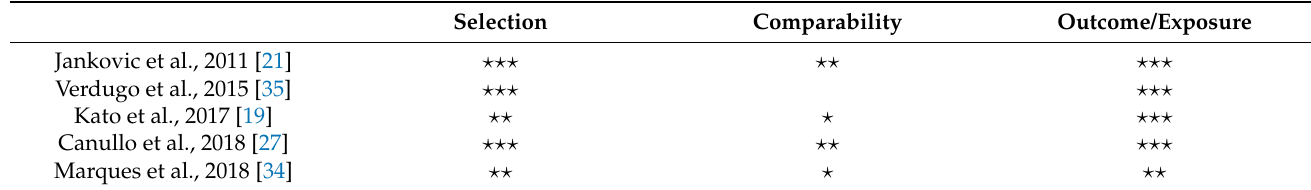
Table 2. Quality assessment of the included studies according to the Newcastle–Ottawa Scale (NOS). Selection Comparability